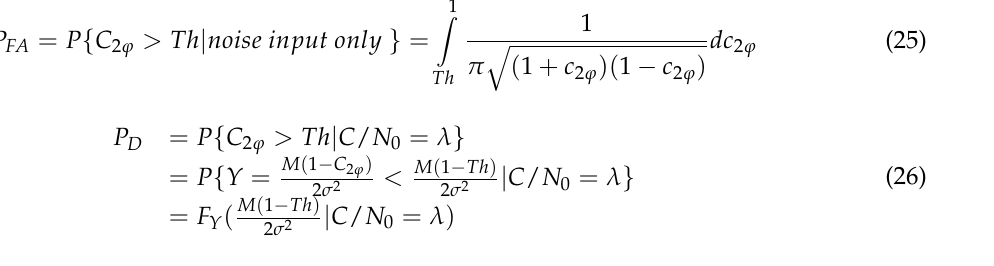
Figure 3. Frequency-locked detector (FLD) output probability density with no signal ( M = 1). 4.1. Lock Probability Analysis of FLD Output The output distribution of FLD is mainly related with the C / N 0 of the received signal. With a given